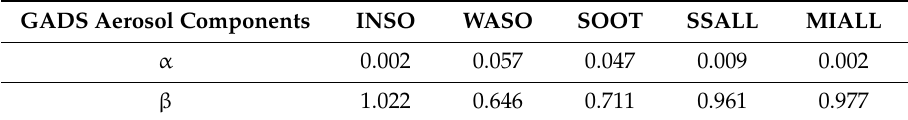
Table 5. Regression coe ffi cients for GADS aerosol components to convert spectral AOD into broadband